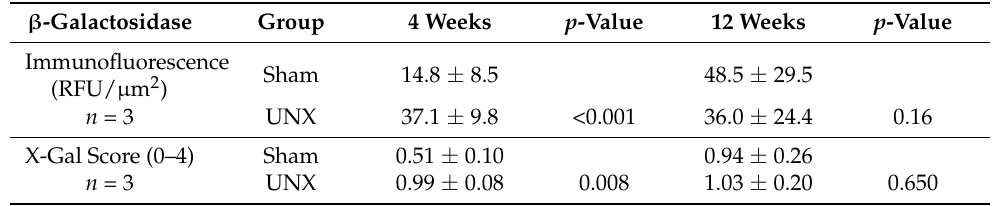
Figure 3. Box-plot distribution of urine albumin/creatinine ratios in TOPGAL animals at the baseline prior to unilateral nephrectomy (UNX) at 4 weeks of age in the sham and UNX groups and at 4 and 12 weeks. These measurements were performed on 12 sham and 12 UNX animals at 4 weeks following UNX and 11 sham and 12 UNX animals at 12 weeks following UNX. The baseline measurements of 4 weeks and 12 weeks animals were combined into a single baseline group. The values for the sham-treated mice are shown in the white boxplots, and those for the UNX mice are shown in the gray boxplots. The circles in box-plot distribution represent outliers. Table 2. Expression of β -galactosidase determined using immunofluorescence and X-gal staining in TOPGAL animals at 4 and 12 weeks following unilateral nephrectomy or sham treatment at 4 weeks of age. The measurements were performed in 3 sham and 3 UNX animals at 4 weeks and 12 weeks in separate sets of animals. No single animal was studied using two methods to demonstrate a change in β -galactosidase. The values are shown as the mean ± SD; the p -values were obtained using an unpaired Students’ t -test. RFU- Relative Fluorescence